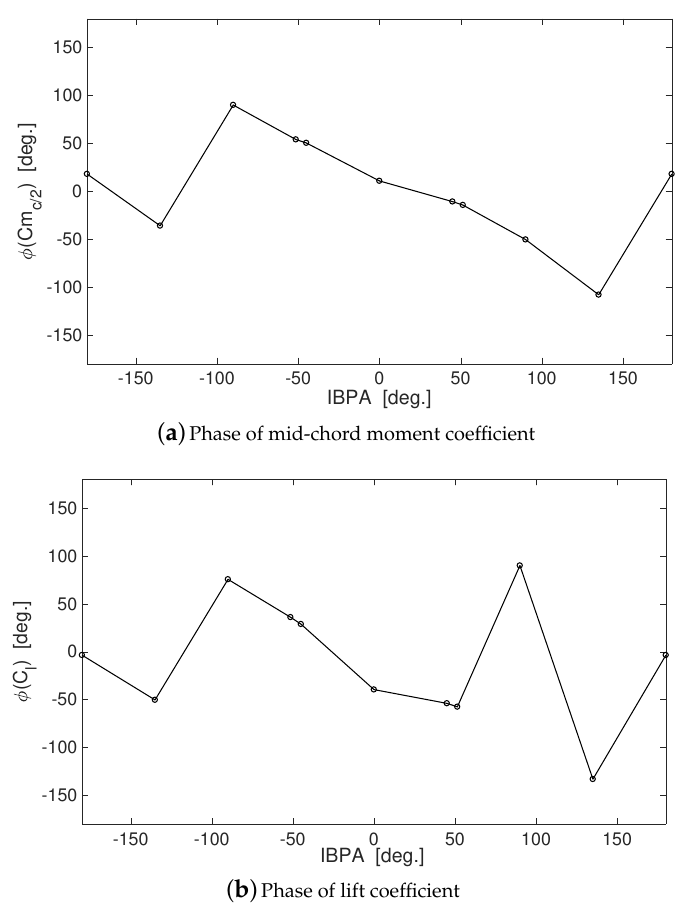
Figure 11. Phase of mid-chord moment coefficient and of lift coefficient at different IBPAs; Re ∼ 195,000; ) degrees; f = 19.17 Hz, T = α = 2 + sin ( 2 π f t + 4 × IBPA π 180